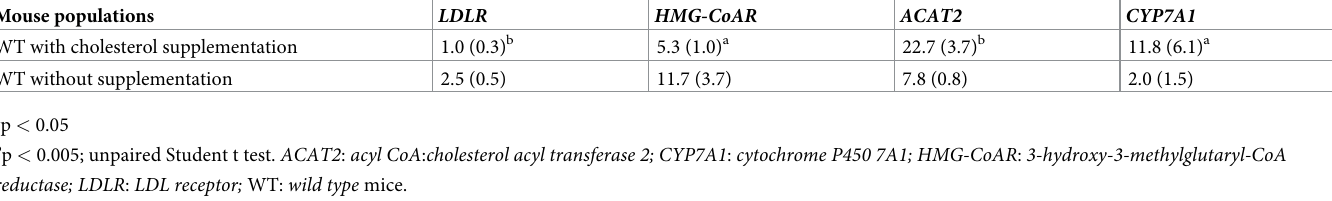
Table 2. Comparison of liver mRNA expression in WT mice with and without cholesterol-supplementation. Mouse